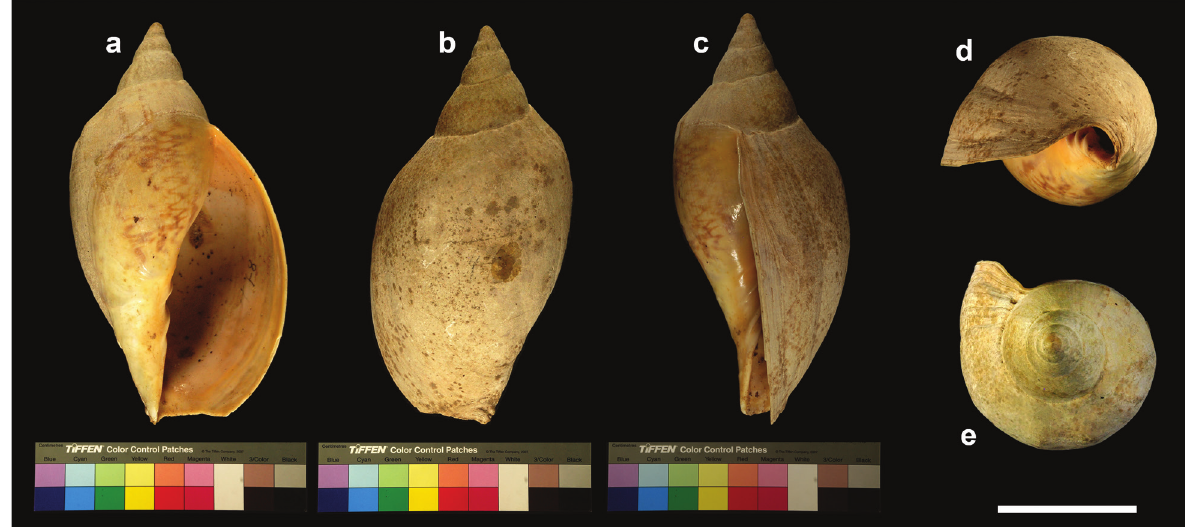
Figure 1. Voluta ambigua typica , specimen figured by Lahille (1895: pl. XII, fig. 16). a Apertural view b Dorsal view c Lateral view d Umbilical view e Apical view. Scale bar: 5 cm.